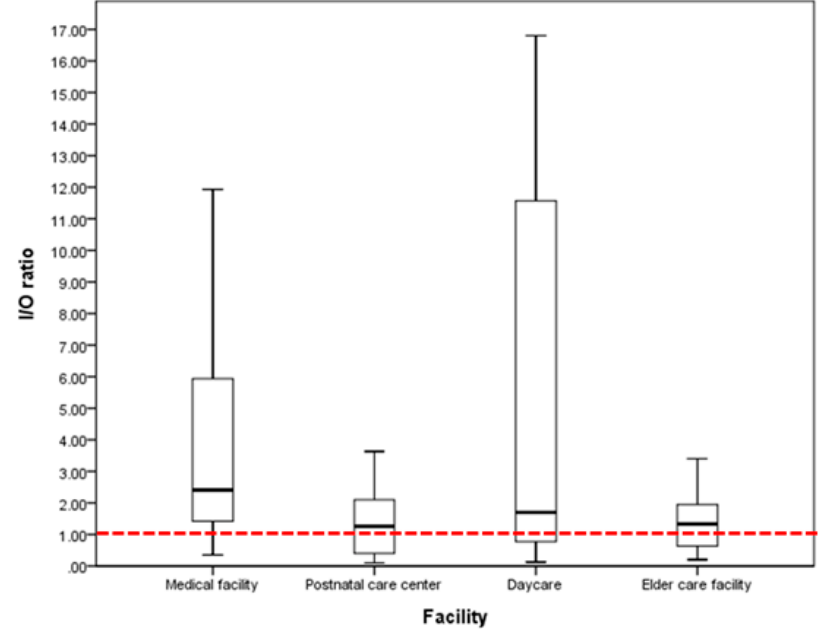
Figure 3. Indoor / outdoor airborne bacterial concentration ratio for each target Figure 3. Indoor/outdoor airborne bacterial concentration ratio for each target facility.